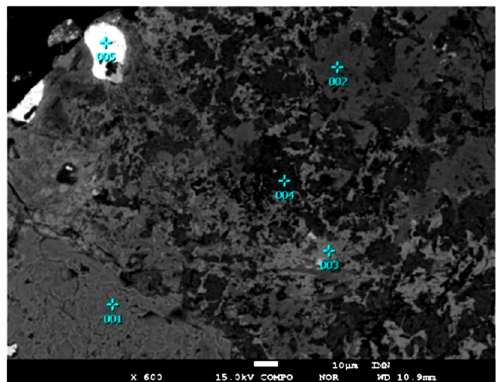
Figure 2. Sample WZI—example of an image of the investigated micro-areas. 1—wustite with Zn admixture (9%), 2—wustite with silicate admixtures, 3 and 4—wustite with Sb admixture (17–22%), 5—Pb oxide.